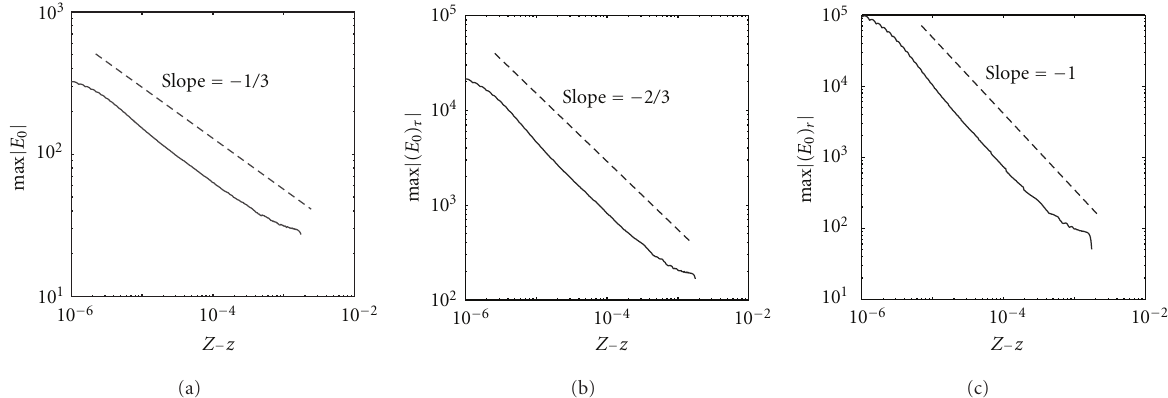
Figure 5: The maximum amplitude of E 0 and its derivative during the collapse. The results are consistent with the power law behavior (22) derived in the text.